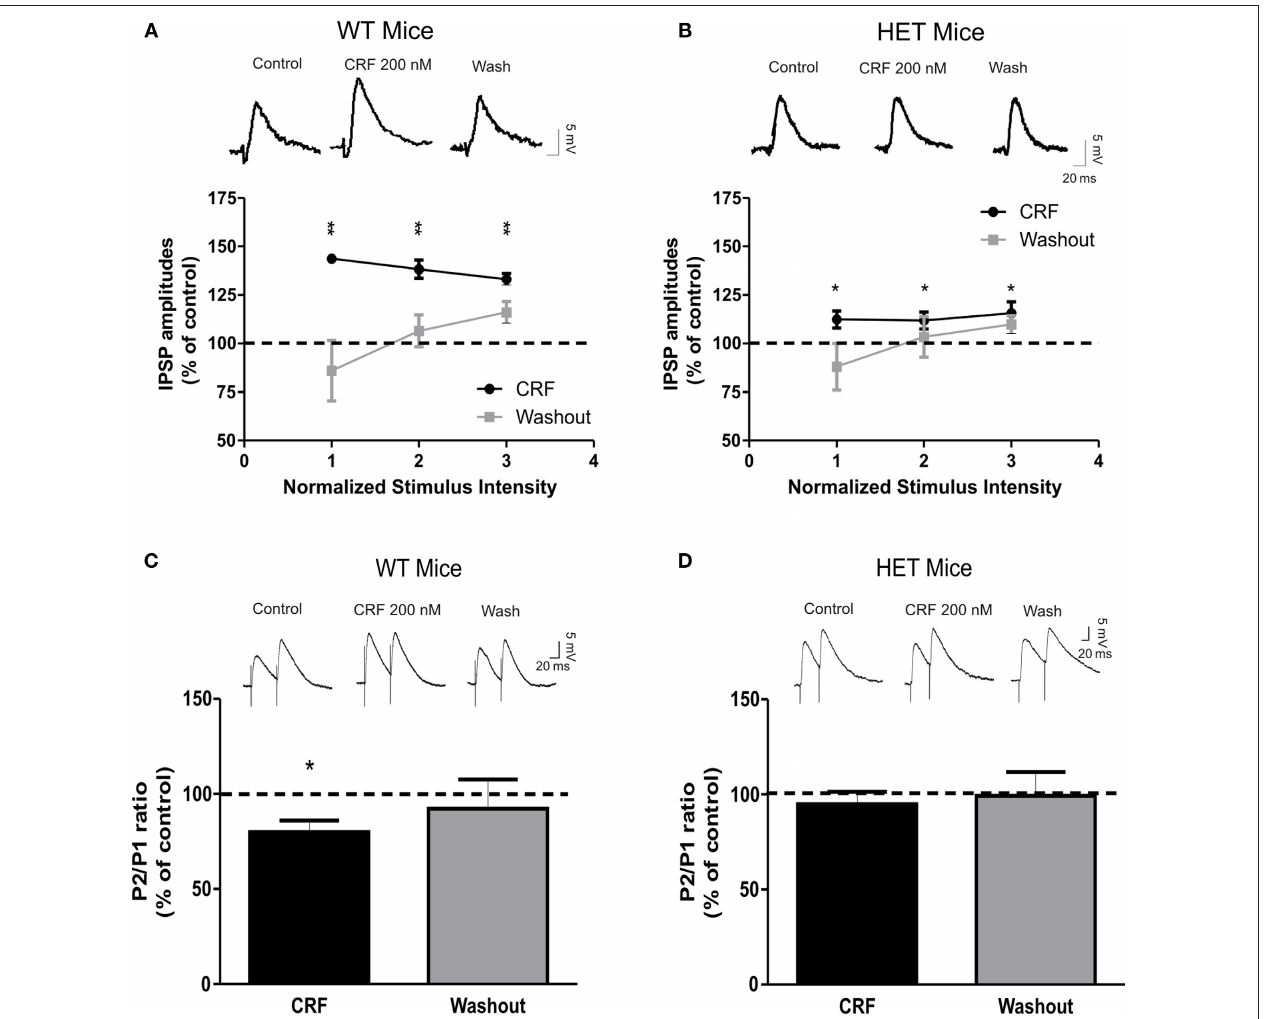
recordings from the CeA neurons of WT and HET mice. (C) Superfusion of CRF significantly decreased PPF in CeA slices from WT ( n = 8) mice, but had no effect on PPF in HET mice [ n = 11; (D) ]. Top panels show representative recordings from PPF experiments. Data presented as mean ± SEM. Statistical significance calculated by Student’s t -test and set at * P < 0.05 and ** P <